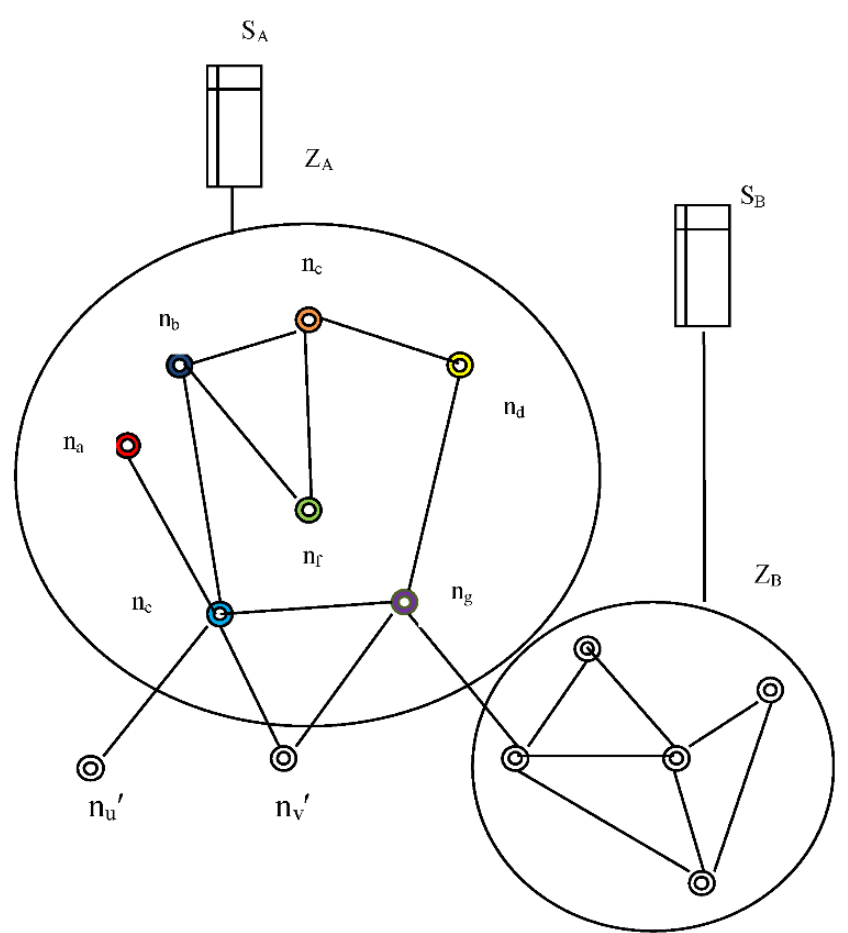
Figure 10. Topology of zones Z A and Z B along with neighbors.